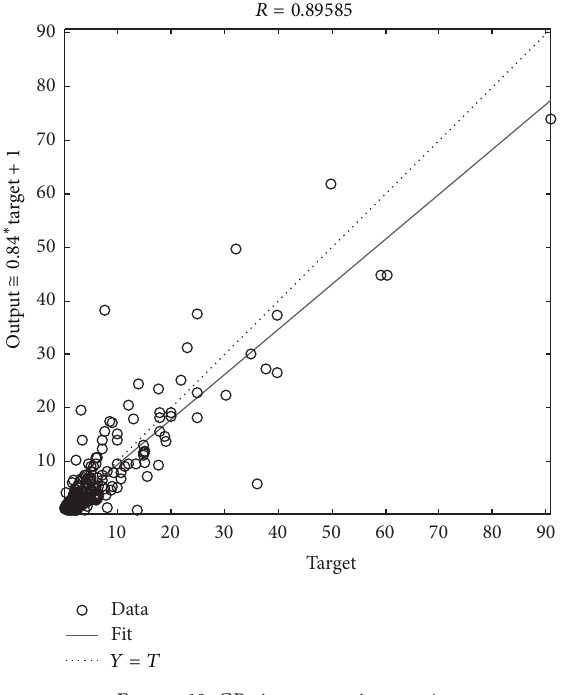
Figure 11: GP zinc expression no.